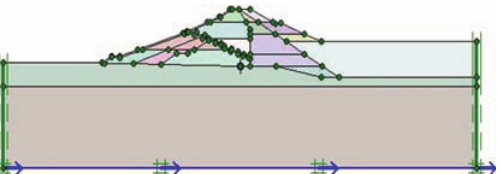
Figure 2: The sliding failure zone in Kitayama dam caused by Kobe 1995 earthquake.